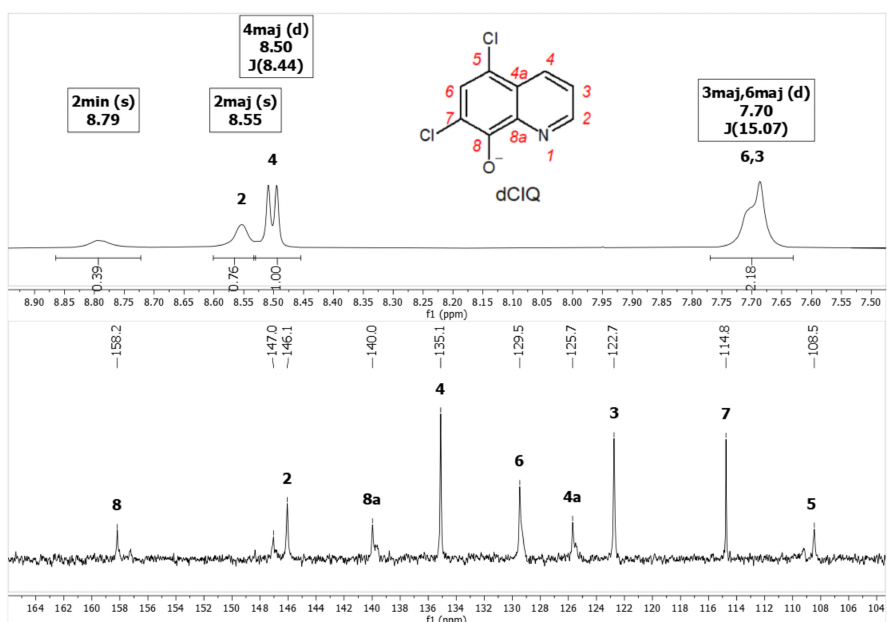
Figure 3. 1 H (600 MHz, DMSO-d 6 ) and 13 C (150 MHz, DMSO-d 6 ) NMR spectrum of complex 4 .